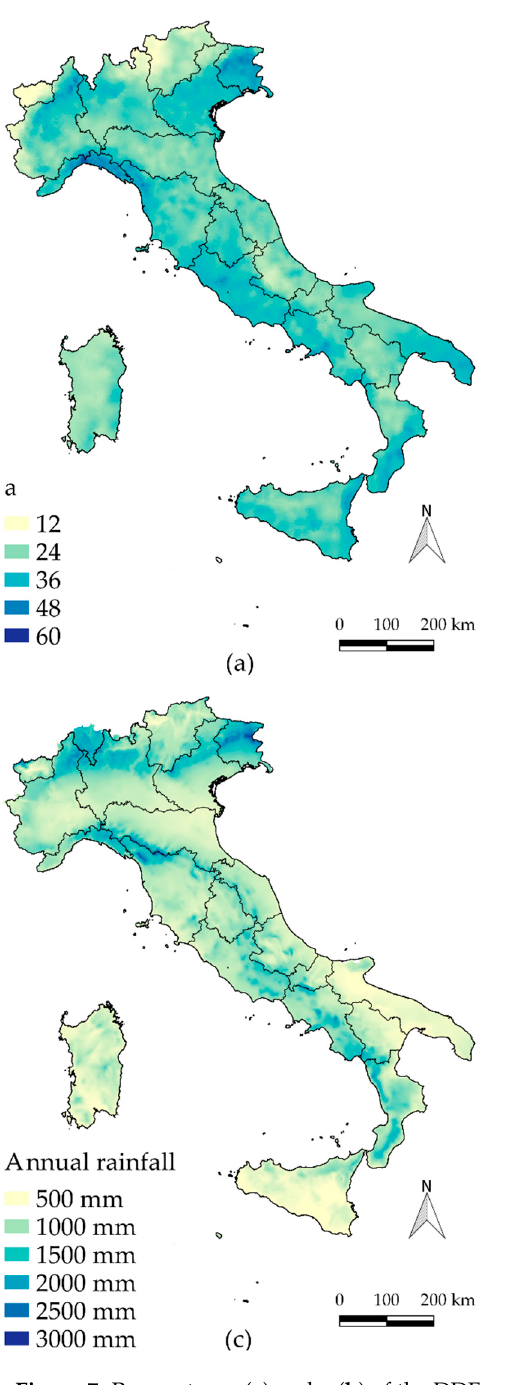
Figure 7. Parameters a ( a ) and n ( b ) of the DDF curves evaluated on the basis of the data contained in I 2 -RED. The maps are characterized by a 1 × 1 km spatial resolution. ( c ) Mean annual precipitation as